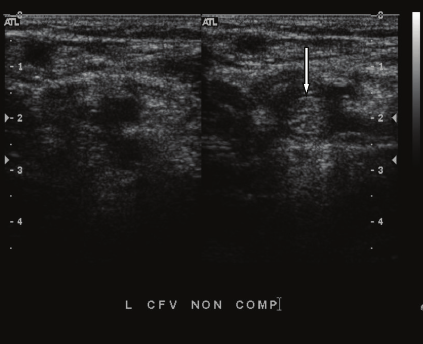
Figure 1: Grayscale ultrasound transverse image demonstrating a thrombus on the left common femoral vein. White arrow is pointing to the intraluminal echogenic material and noncompressibility, findings compatible with deep vein